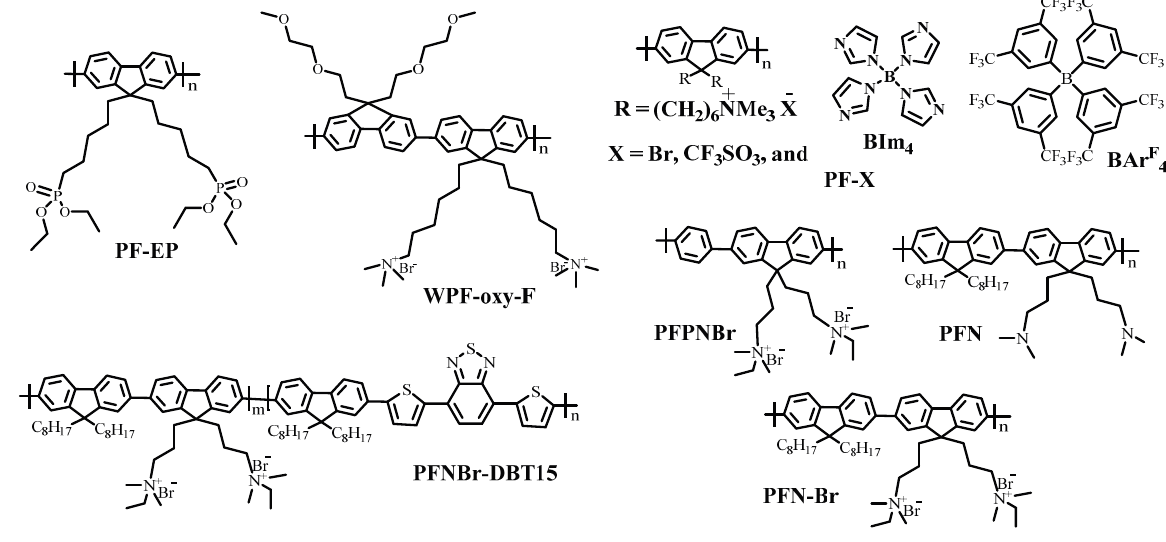
Figure 5. Chemical structures of water/alcohol soluble conjugated polymers as interfacial layer materials for polymer solar